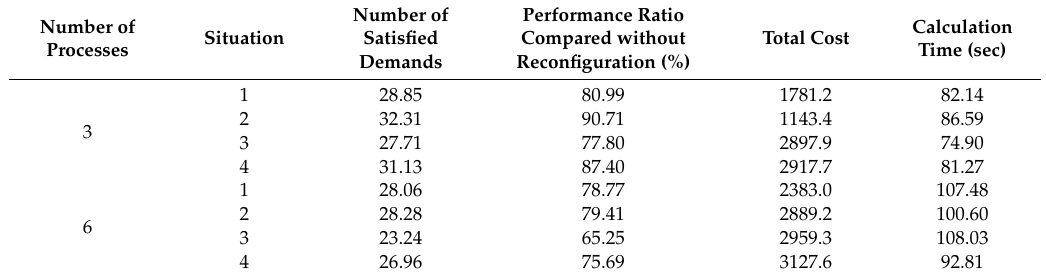
Table 8. Experimental result according to the number of processes and reconfigurable situations.